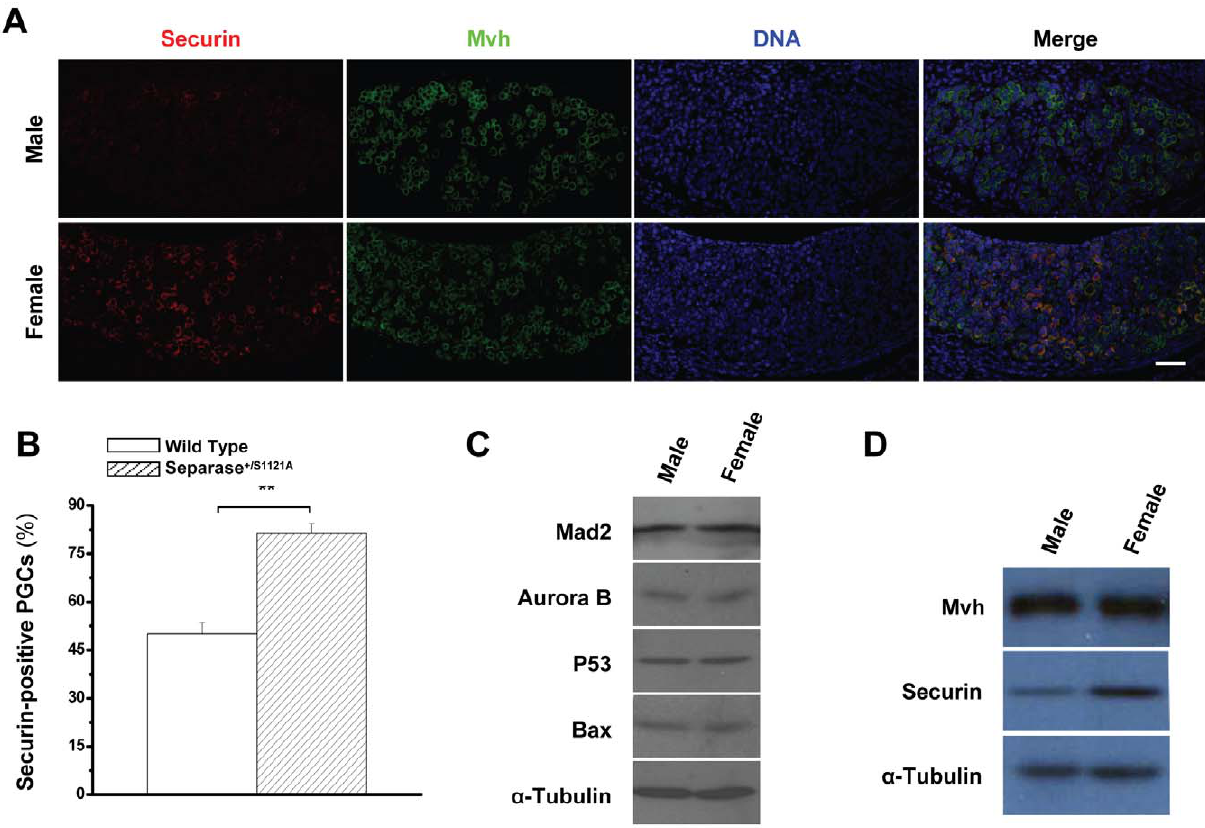
Figure 5. More Securin expression in female PGCs. A. Securin levels of PGCs at 13.0 dpc observed by immuno-staining with Securin (red), Mvh (green) and DNA (blue). Bar=5.0 m m. B. Quantitative analysis of Securin-positive PGCs in male and female gonads at 13.0 dpc. Serial sections of female genital ridges were stained for DNA, Mvh, and Securin. All Mvh-positive cells and the Mvh and Securin double positive cells were scored from at least three sections in at least three embryos (six genital ridges) for each time point. The mean value is shown with standard error (** p , 0.001, T test). C. Western blot detection of Mad2, Aurora B, P53, and Bax of gonads at 13.0 dpc. D. Western blot detection of Mvh and Securin of gonads at 13.0 dpc.